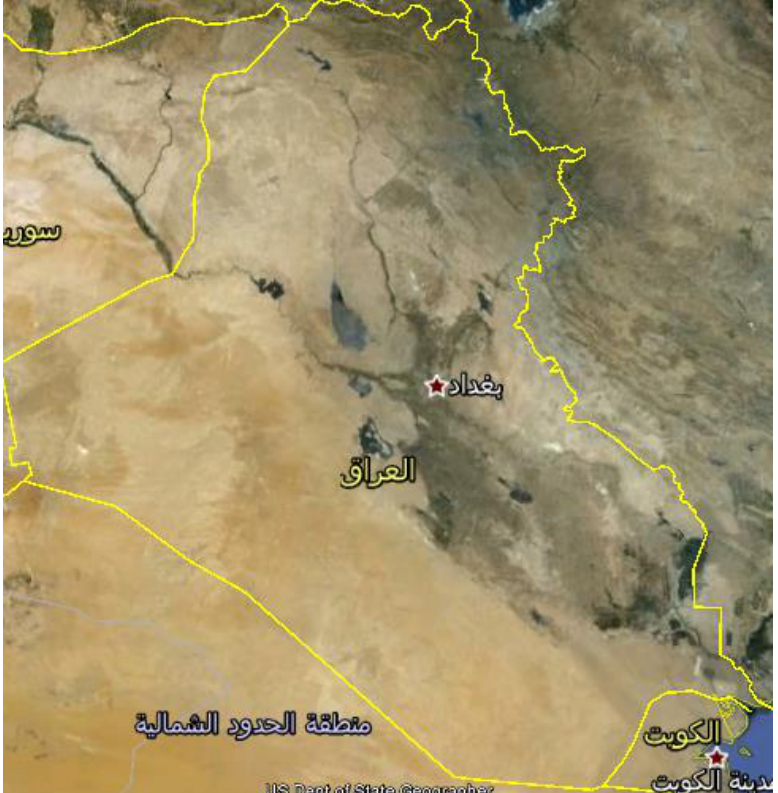
Fig. 2: Illustrated Iraq country region and Baghdad city